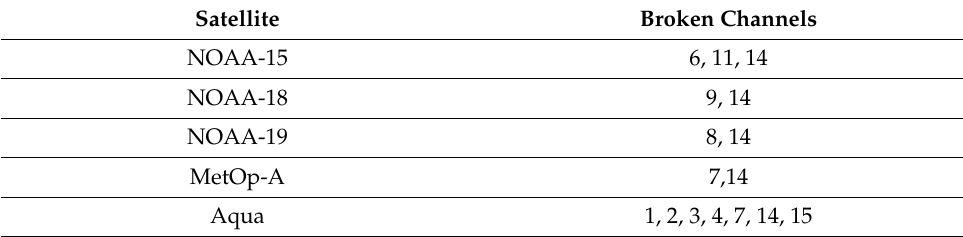
Table 2. Broken channels onboard satellites holding AMSU-A sensors.